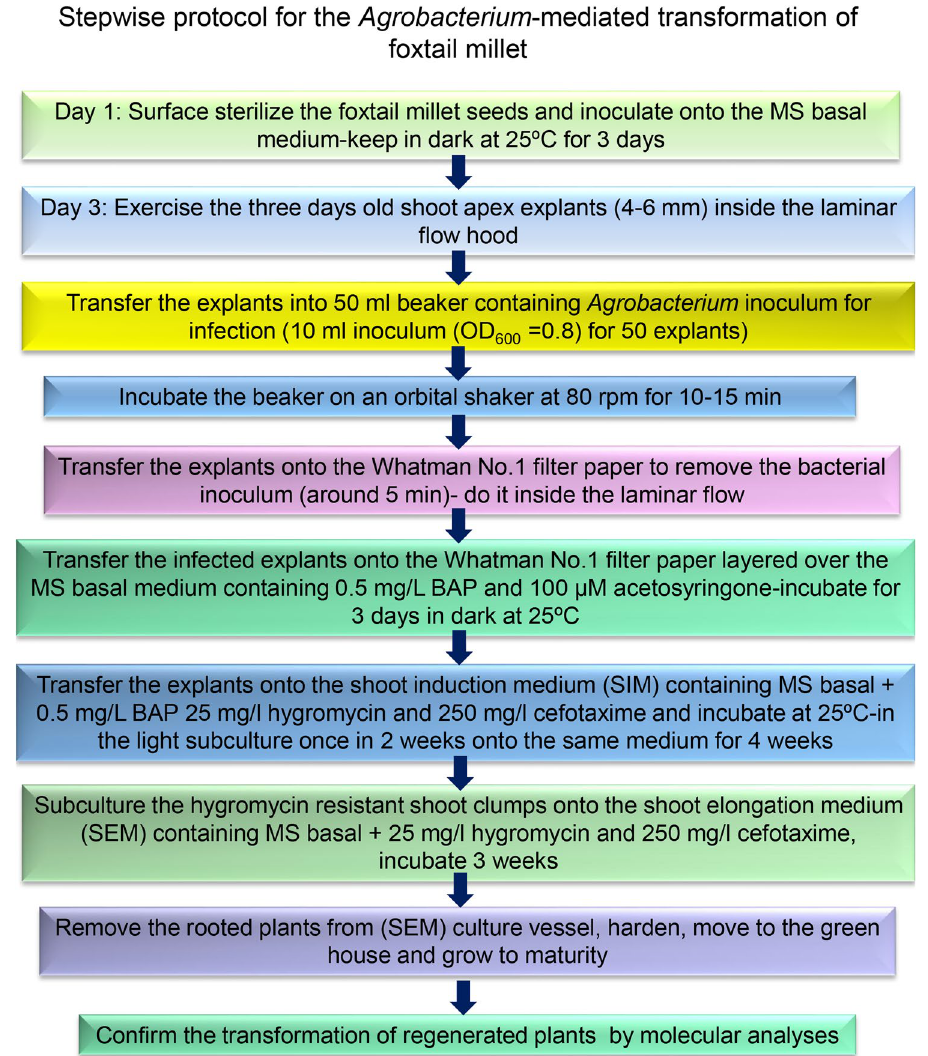
Figure 3. Stepwise protocol for Agrobacterium -mediated transformation of foxtail millet using shoot apex